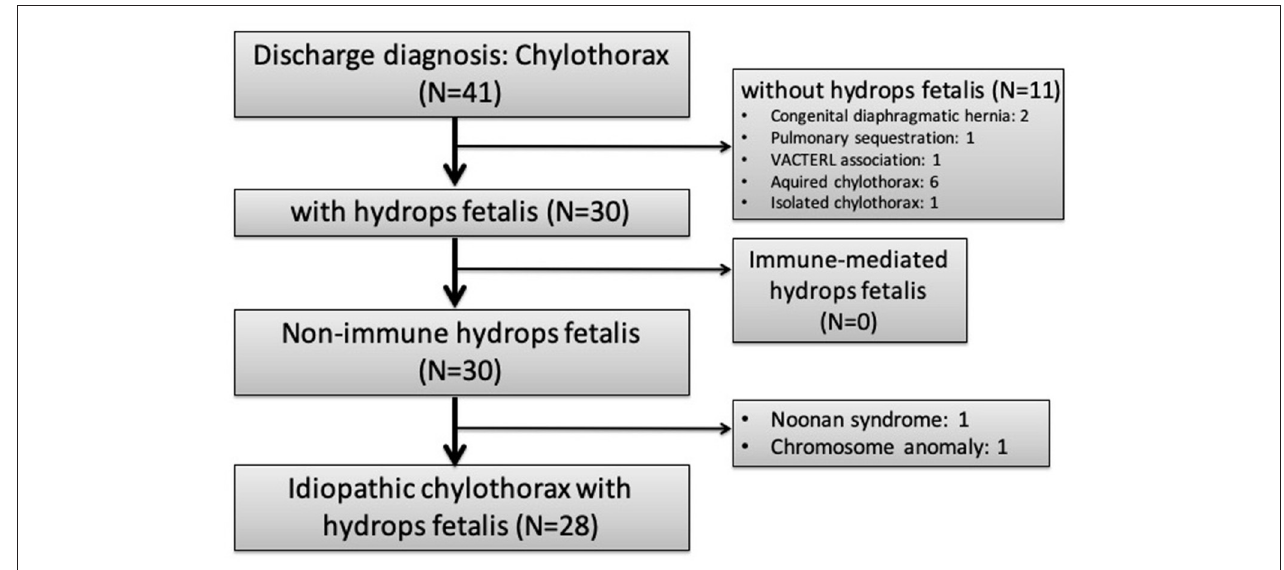
FIGURE 1 | Flow chart of patient enrollment.